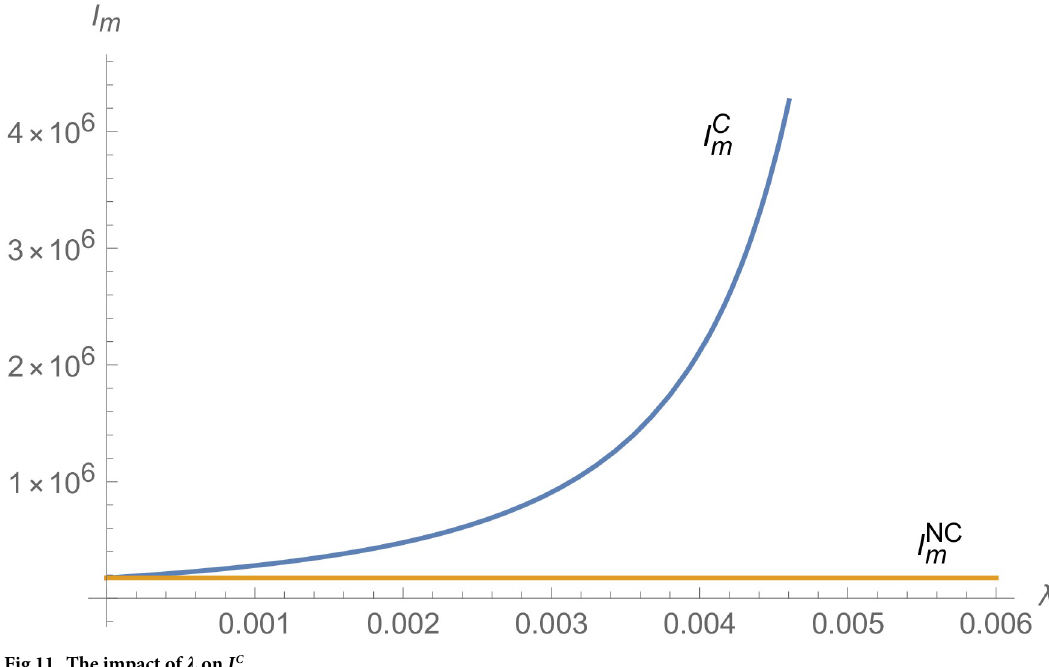
Fig 11. The impact of λ on I C